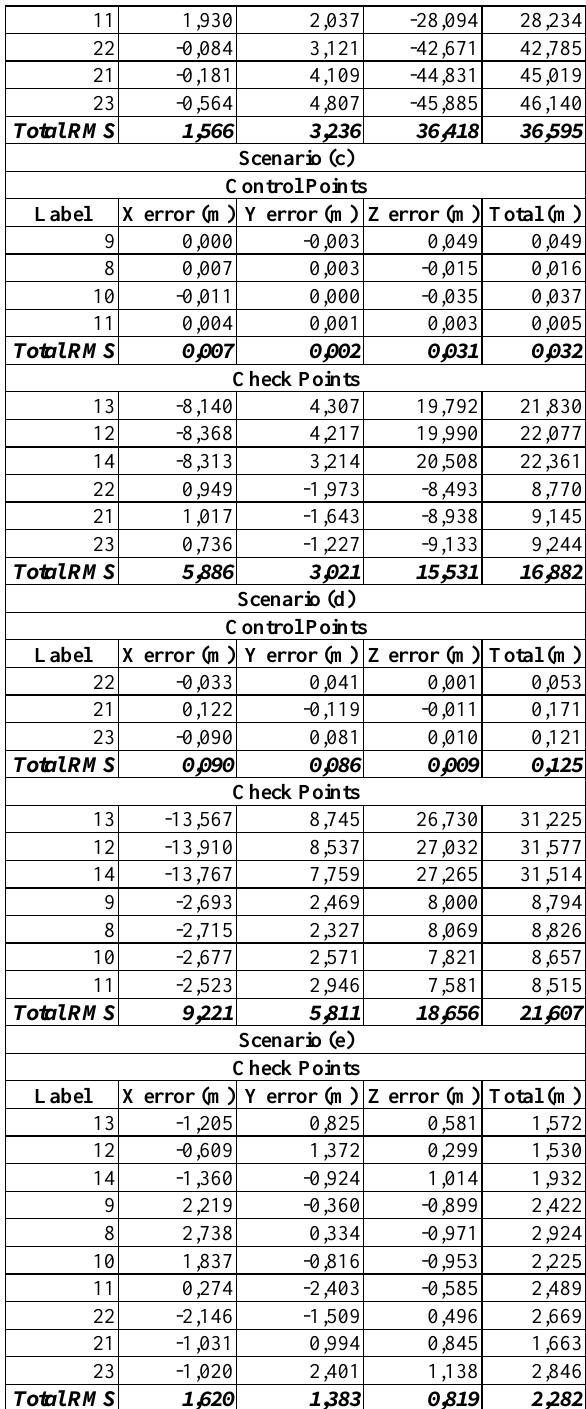
Table 1. GCP and CP errors for different scenarios Spatial analysis statistics were also calculated to demonstrate the difference between the 6 GCP calibrated DSM and the ones from the different scenarios. The resulting figures are presented for different scenarios accuracy comparison along with statistical metrics of MIN, MAX, MEAN and STD. DEV.